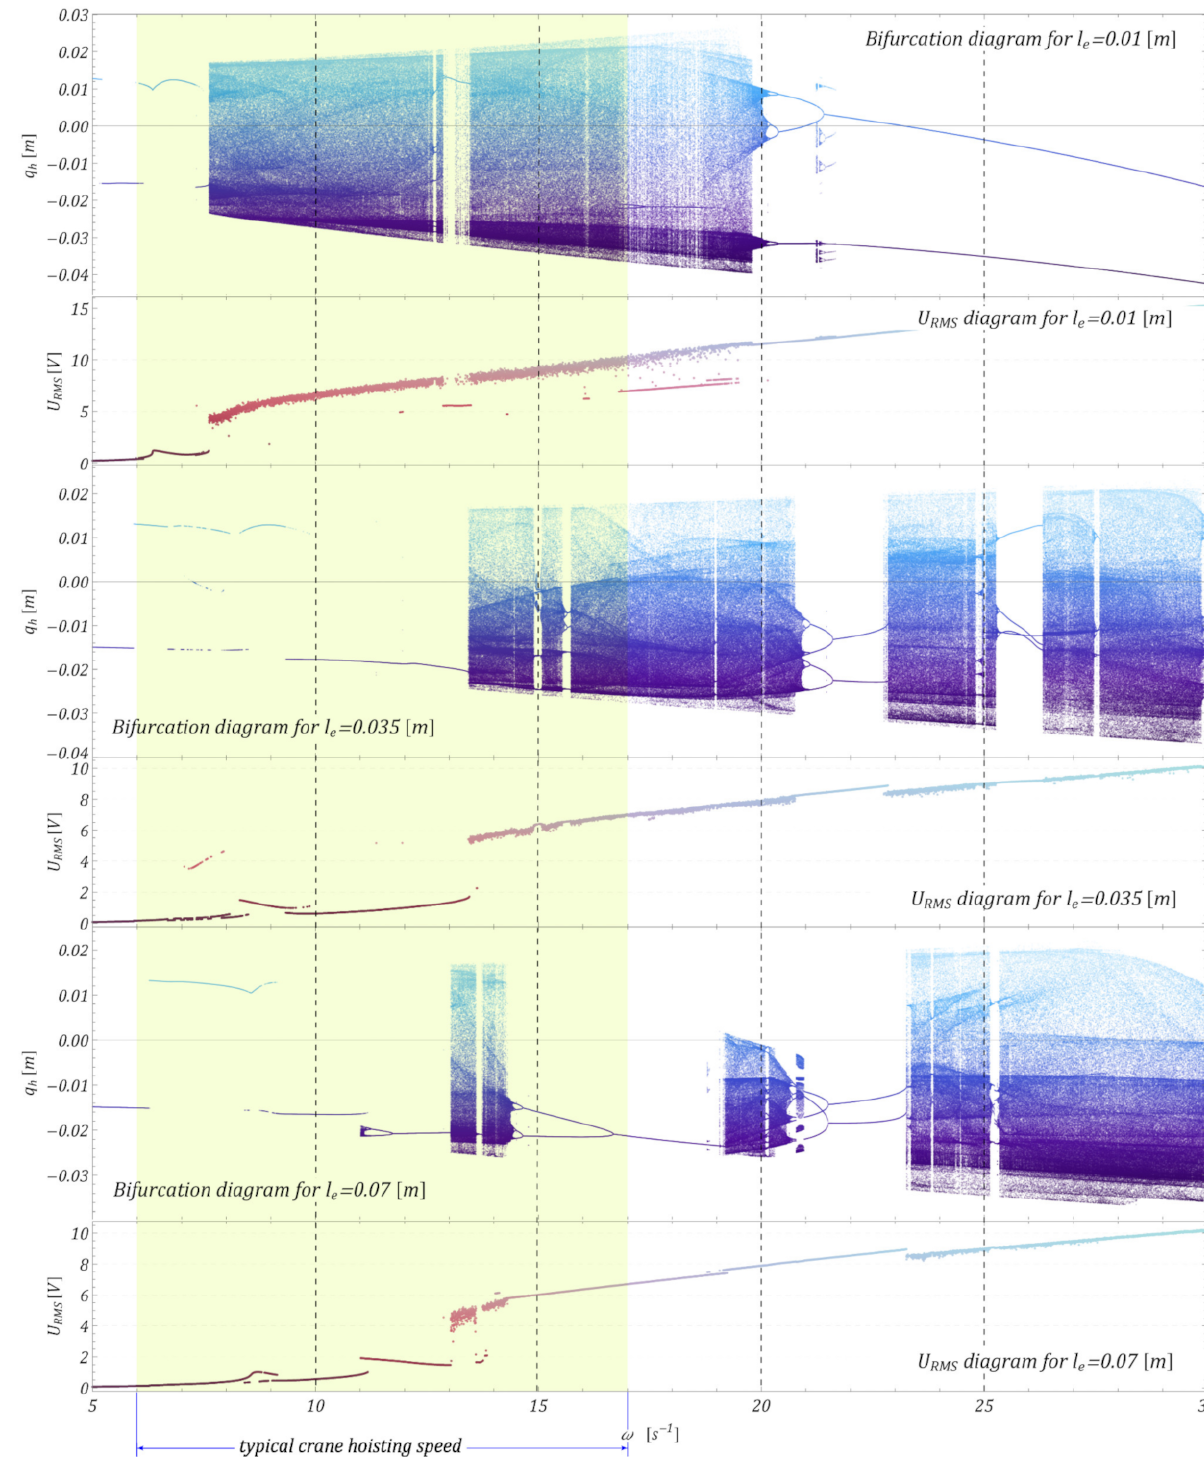
Figure 10. Examples of computer simulation results plotted against selected values of the arm length and frequency of excitation affecting the energy-harvesting system (bifurcation diagram, RMS voltage